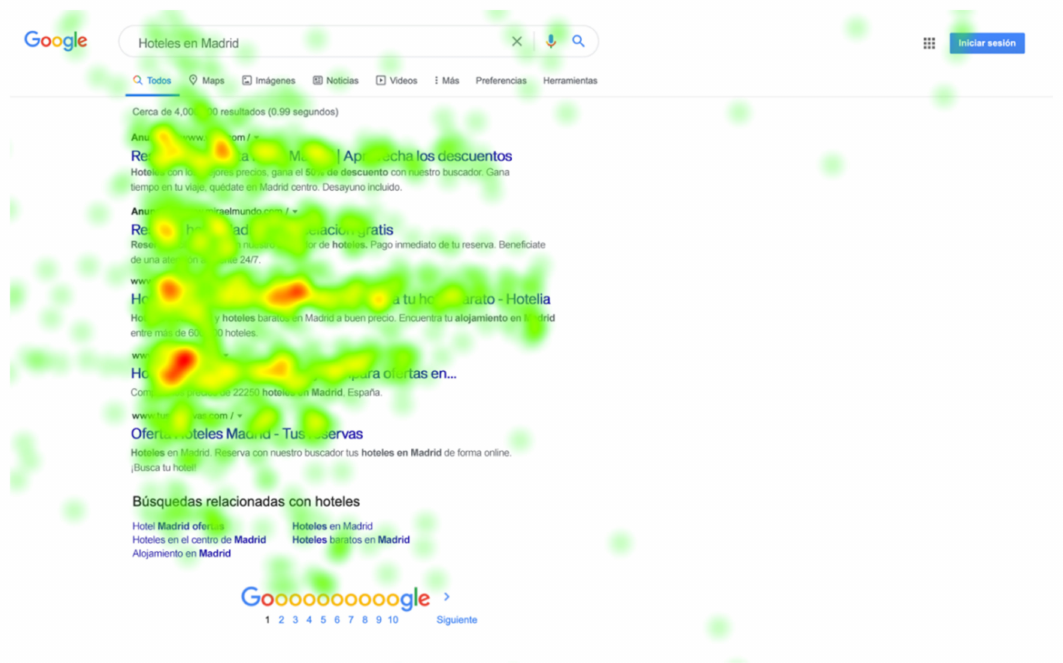
Figure 6. Heatmap for the PRO condition.